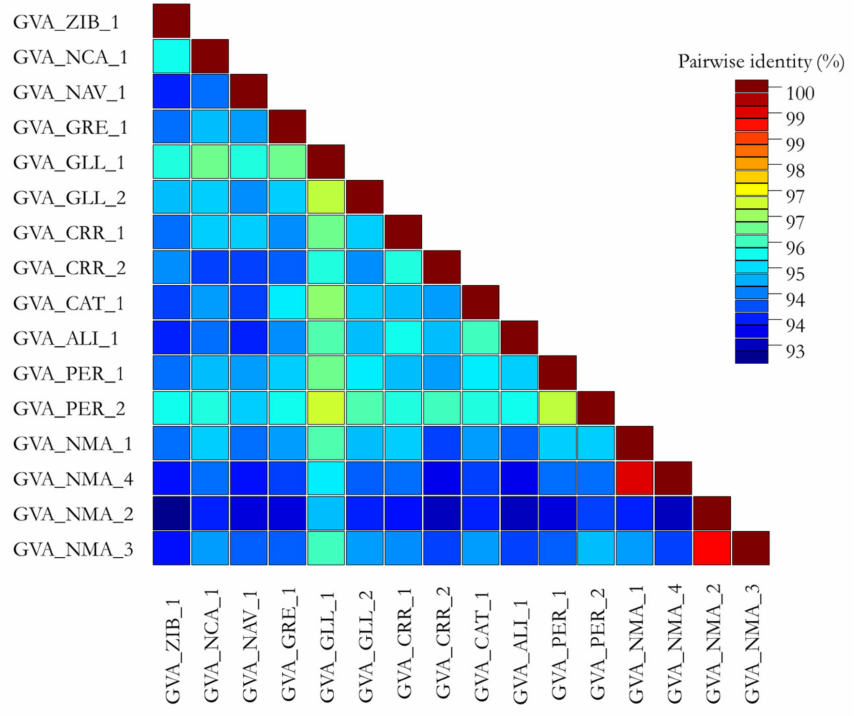
Figure 2. Graphical representations of pairwise percent identity of nucleotides of the sequenced CP gene between the GVA isolates from Sicily (Italy) using Sequence Demarcation Tool v1.2 program. Each colored key represents a percentage of the identity score between two